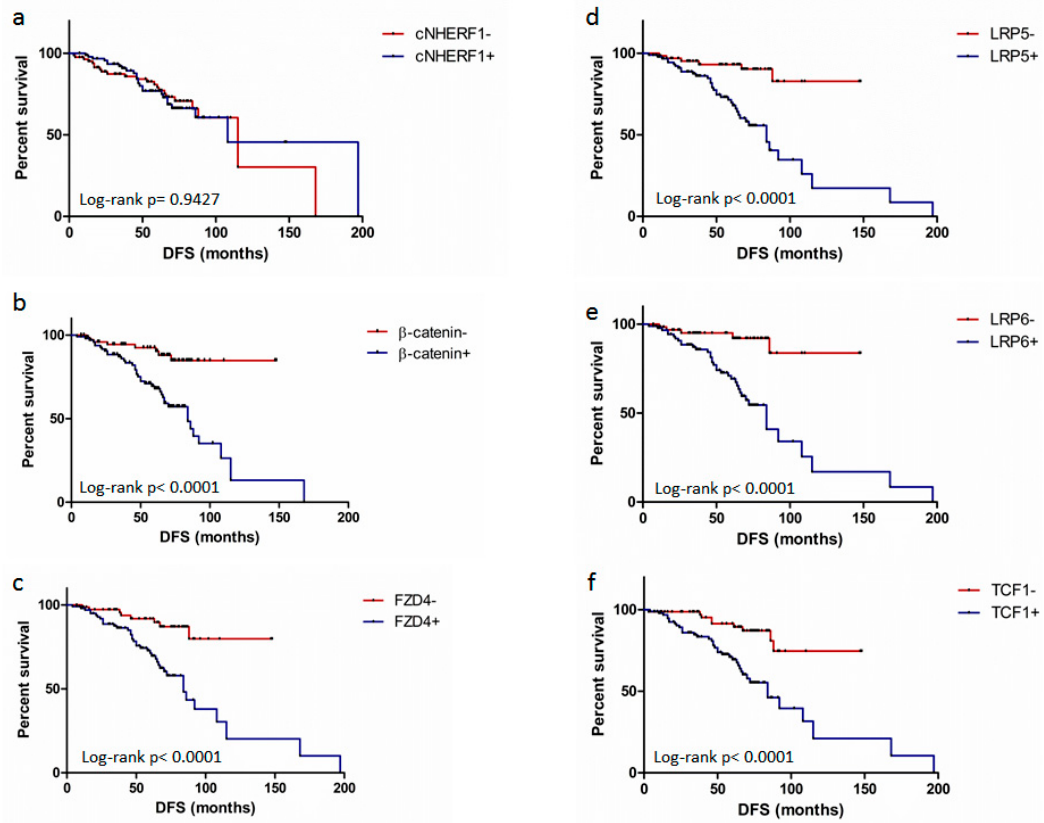
Figure 2. Survival analyses. Disease-free survival (DFS) curves for patients with ( a ) (cytoplasmic Na+/H+ Exchanger Regulatory Factor 1) cNHERF1– versus cNHERF1+ expression ( p = 0.9427); ( b ) β -catenin- versus β -catenin+ expression ( p < 0.0001); ( c ) (Frizzled receptor 4)FZD4– versus FZD4+ expression ( p < 0.0001); ( d ) (Low-density lipoprotein receptor-related protein LRP 5) LRP5– versus LRP5+ ( p < 0.0001); ( e ) (Low-density lipoprotein receptor-related protein LRP 6) LRP6– versus LRP6+ ( p < 0.0001); ( f ) T-cell factor 1 (TCF1) TCF1– versus TCF1+ ( p < 0.0001).